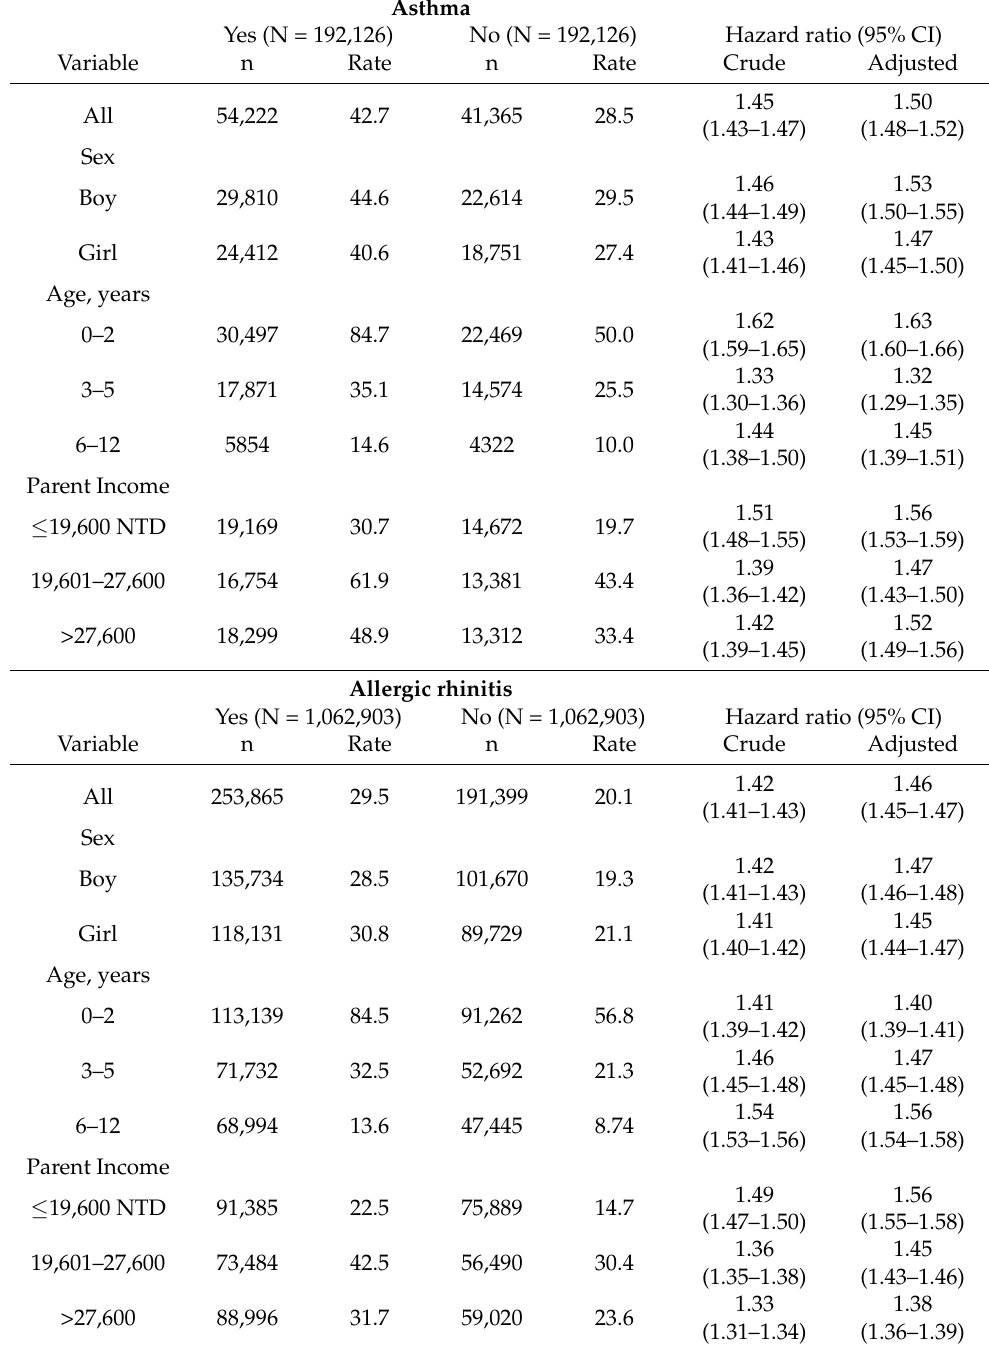
Table 3. Incidence number and rate of acute bronchiolitis, asthma cohort to non-asthma cohort hazard ratio and allergic rhinitis cohort to non-allergic rhinitis cohort hazard